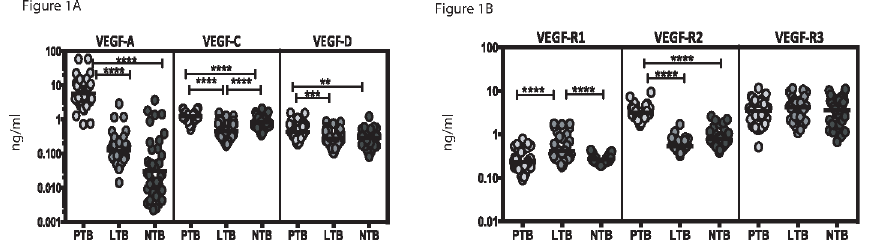
Fig 1. Elevated systemic levels of circulating angiogenic factors in PTB individuals. The plasma levels of (A) vascular endothelial growth factors (VEGF-A, C and D) and (B) VEGF-receptors (VEGF-R1, R2 and R3) were measured in PTB (n = 44), LTB (n = 44) and NTB (n = 44) individuals. The data are represented as scatter plots with each circle representing a single individual. P values were calculated using the Kruskal- Wallis test with Dunn's post hoc